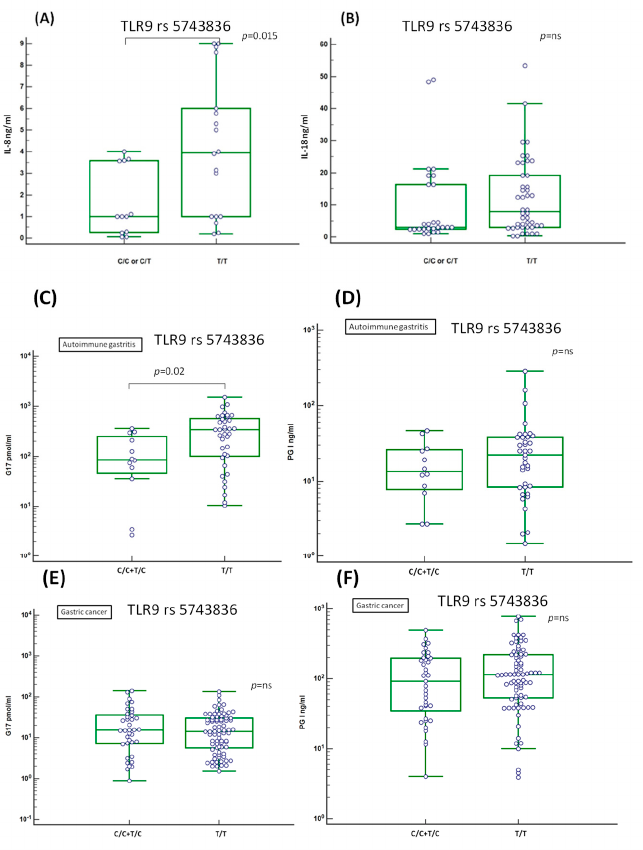
Figure 6. Cytokines, gastrin G17 and pepsinogen PGI association with TLR9 polymorphism. ( A ) IL-8 and ( B ) IL-18 cytokines titer were tested using a Luminex MagPlex based assay and result stratified based on the carriers TLR9 rs5743836 polymorphism. A significant increase in the mean IL-8 titer was found associated with the presence of the TLR9 T / T genotype ( A ). Samples tested were n = 70 GC, samples duplicated with a CV > 15% were excluded from the analysis and they are not reported in the figure. The mean of IL-18 levels between the 2 TLR9 genotypes (C / T and C / C vs. T / T) did not reach a statistical di ff erence ( B ). TLR9 T / T genotype was found associated to highest mean level of gastrin G17 in the AAG group ( C ) but not in GC ( E ). TLR9 T / T genotype was found associated with a mean slightly higher PGI level in AAG ( D ) and in GC ( F ), although in both the groups the di ff erence did not reach a significant di ff erence. Compared to AAG, the mean of PG1 level is higher in